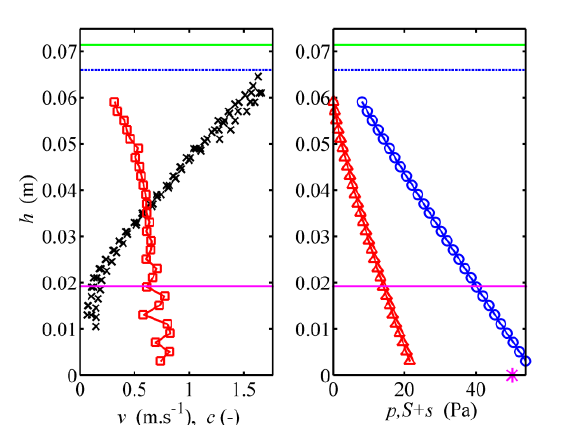
Fig. 5. Distributions in layered flow of FA60-mixture (bed Shields parameter = 1.9). Left plot - measured distribution of volumetric concentration and velocity. Right plot – calculated solids normal stress and total shear stress. Legend: black x – velocity profile, red square – concentration profile, from top to bottom: green line - water surface, blue line – top of transport layer, magenta line - top of dense layer; right plot: red triangle – normal stress, blue circle - total shear stress, magenta star – bed shear stress computed from measured integral data